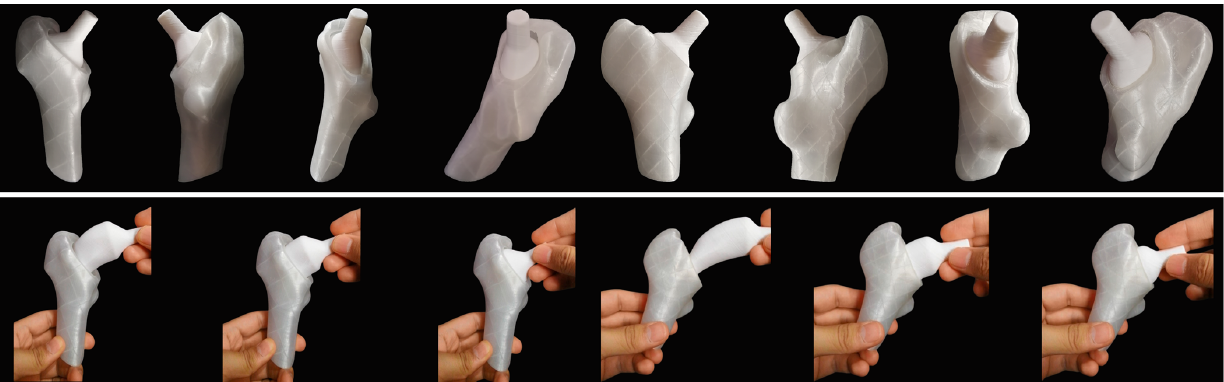
Figure 22. Imitation of the “round the corner” technique for GC1 and GC2.